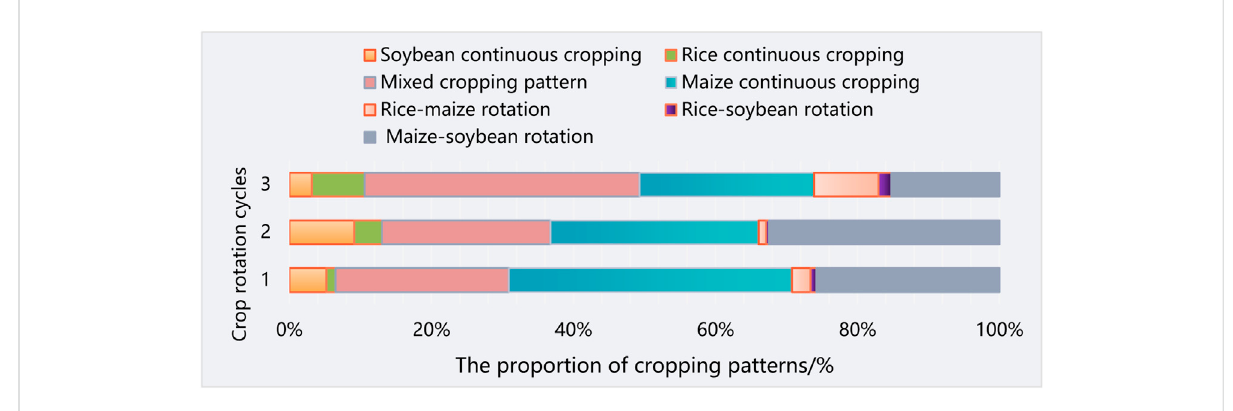
FIGURE 6 The proportion of cropping patterns in different crop rotation cycles.